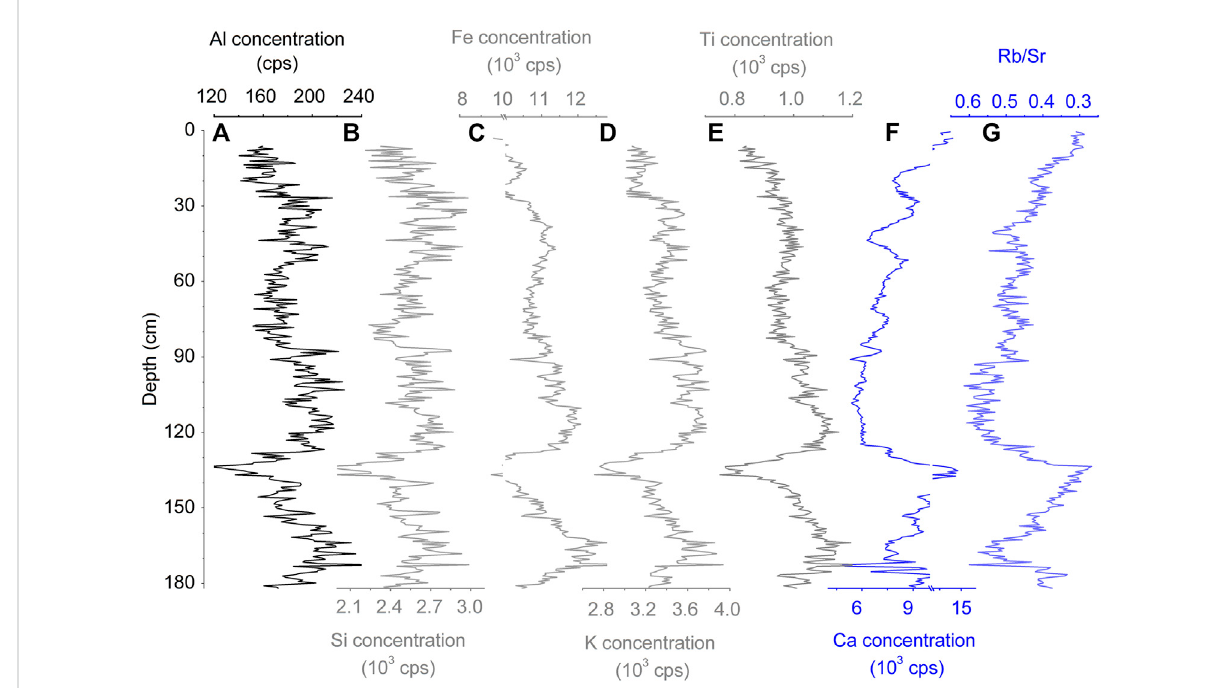
FIGURE 7 Concentration-depth plots of the elements of core GH19C-J: (A – F) Al, Si, Fe, K, Ti and Ca concentrations; (G) Rb/Sr ratios.